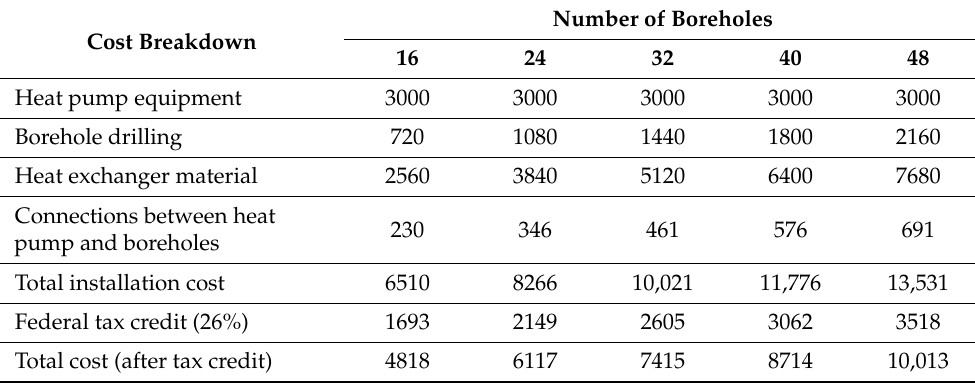
Table 7. Total cost of S-GSHP systems using 4.0 m (13 ft) deep